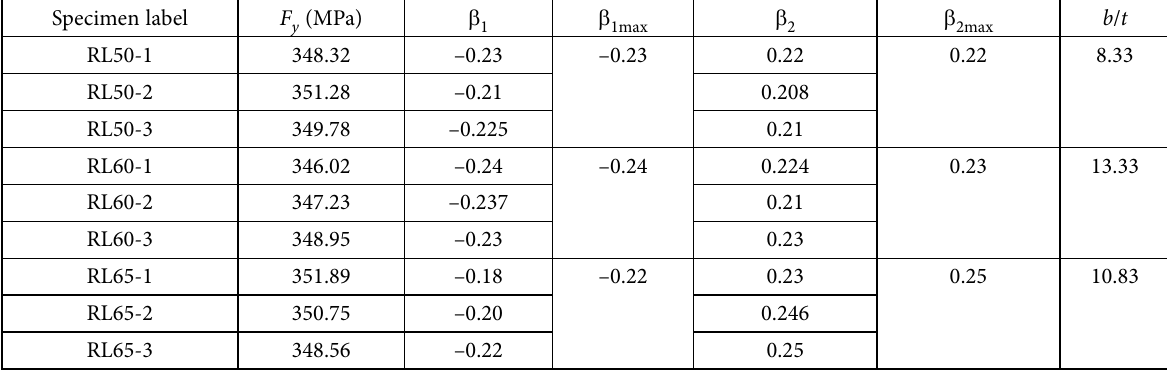
Table 6. Nominal dimensions of specimens and test